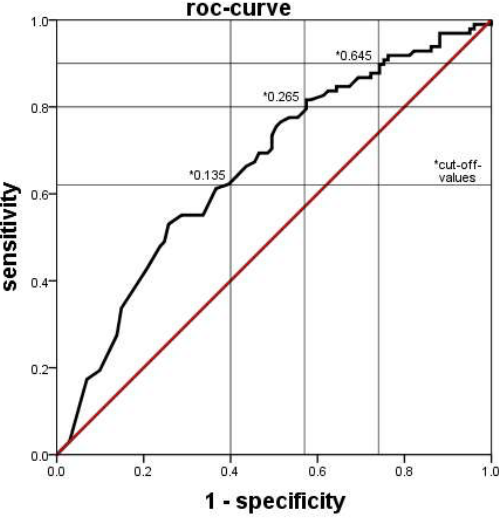
Figure 2. ROC-curve of the diagnostic accuracy of detecting a probable infection by the numbers immature granulocytes as counted by the Sysmex XN-9000 ® . The area under the curve was 0.661. * Several different cut-off values with their respective sensitivity and specificity are indicated.